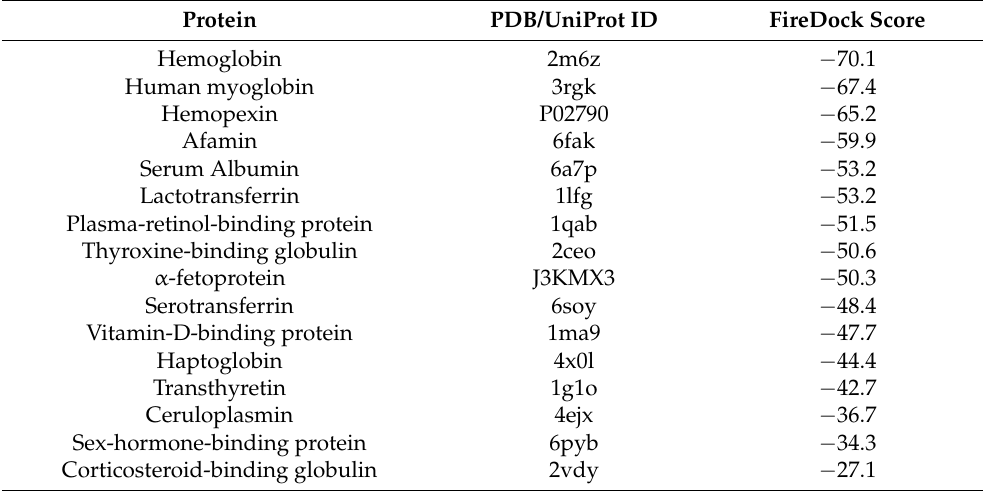
Table 1. Protein target candidates for mTHPC-binding, identified by reverse docking procedure. Only one protein structure, the one interacting the most with mTHPC, is indicated in the